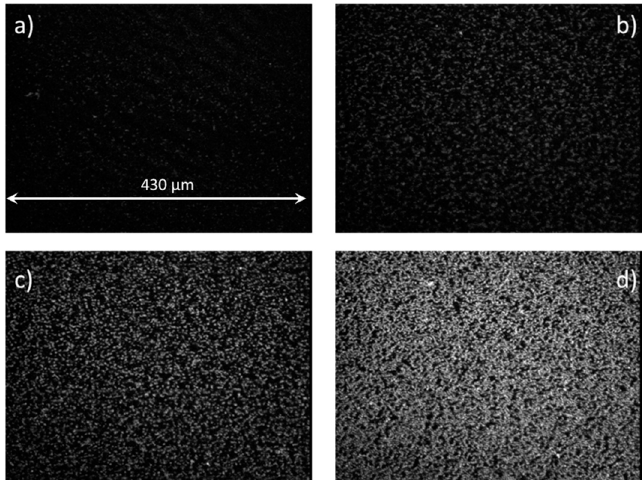
Figure 4. BAM images of CoCoPo2 recorded at different surface pressure values, 5 mN · m − 1 (box a ), 12, 26 and 34 mN m − 1 (boxes b – d ). Width of images is 430 μ m.